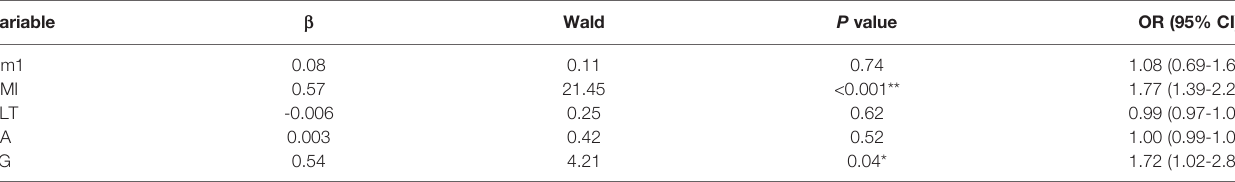
TABLE 5 | Binary Logistic regression analysis between level of Ism1 and T2D&NAFLD. Variable